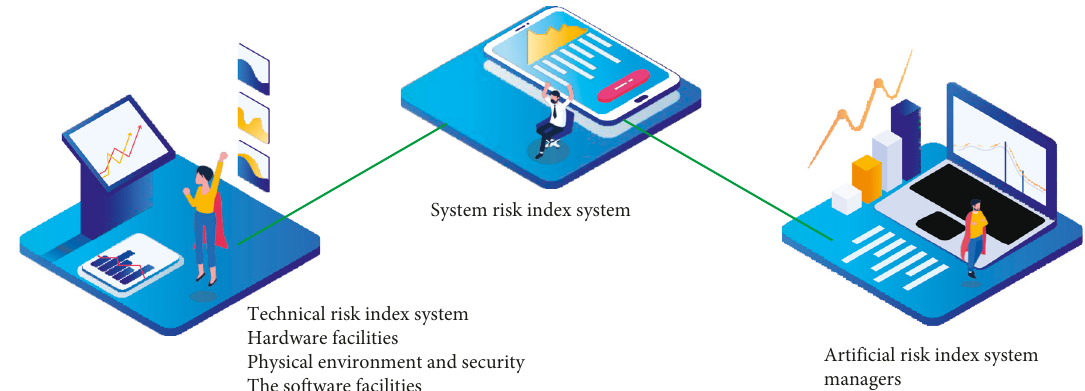
Figure 1: Hierarchical indicator